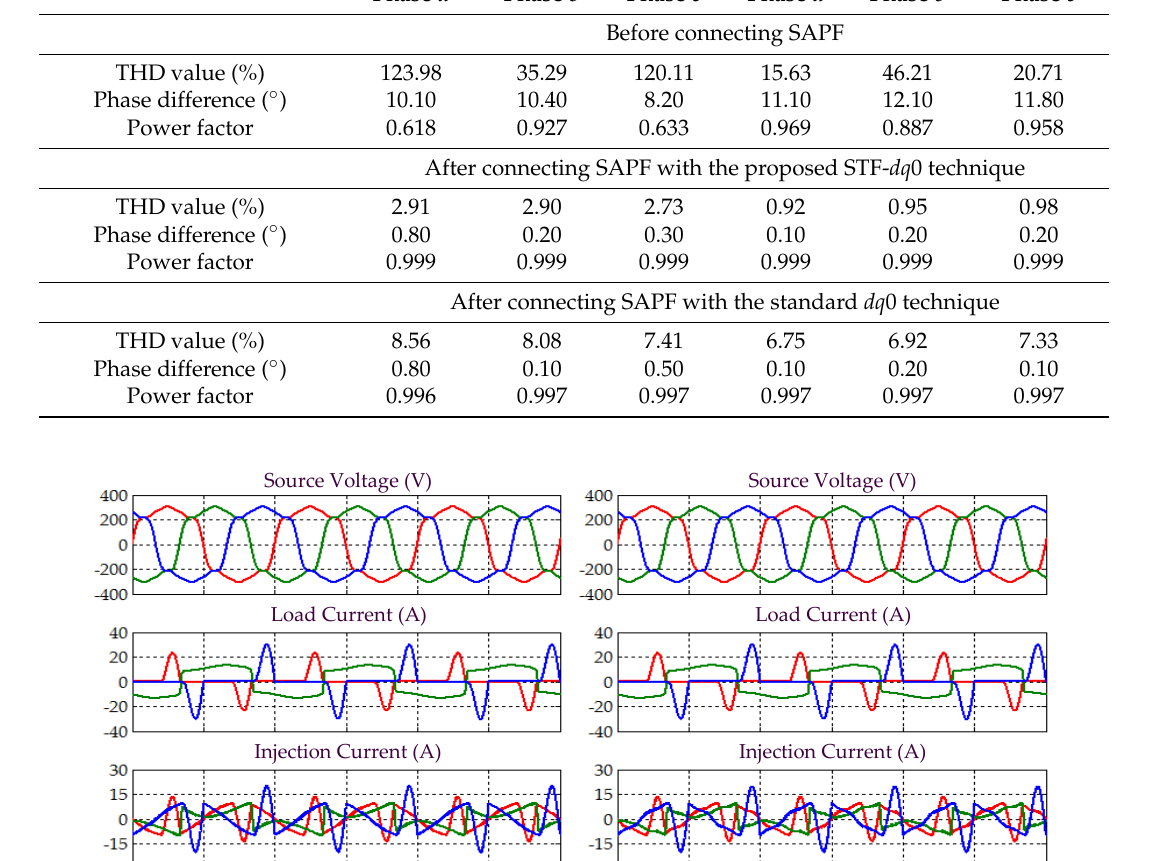
Table 3. Comparative analysis of the proposed STF- dq 0 and the standard dq 0 techniques under Scenario B.